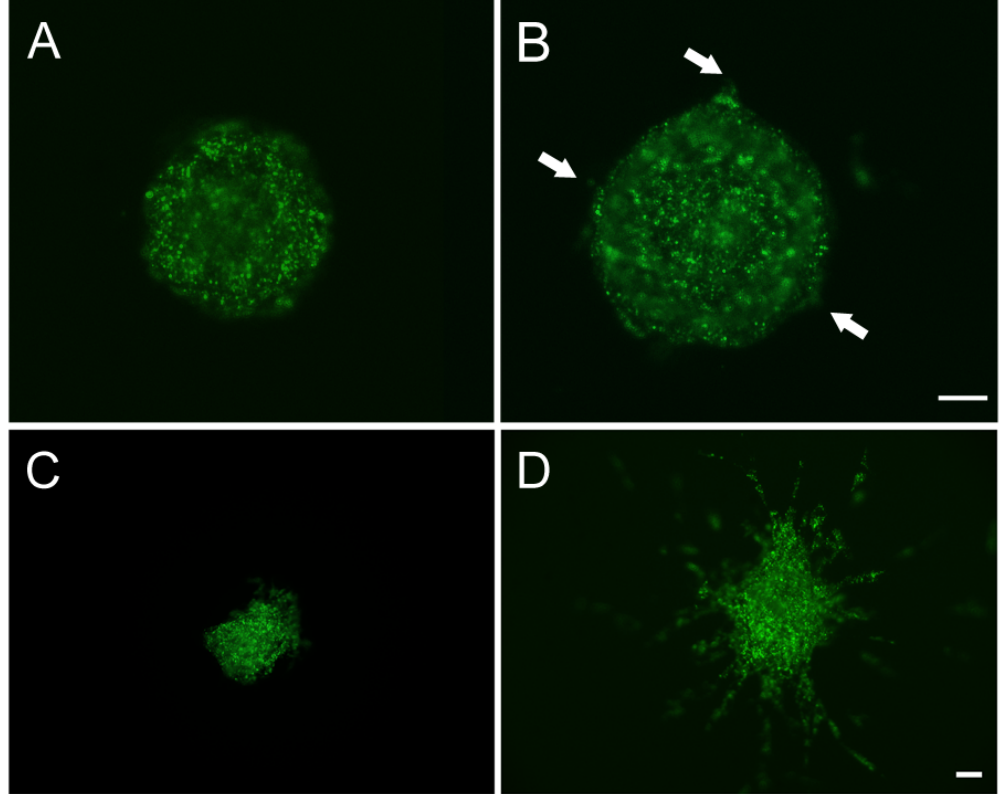
Figure 6. MSC spheroids (10,000 cells/mL) cultured in ( A ) standard media at 3 h; ( B ) 1 ng/mL IL ‐ 6 at 3 h; ( C ) standard media at 24 h; ( D ) 1 ng/mL IL ‐ 6 at 24 h. Arrows indicate initial cellular migration at 3 h. Green indicates presence of mNPs. Images taken with Zeiss Axio Vert A1 fluorescent microscope (excitation = 365 nm and emission = 420 nm). Scale bar = 10 μ m.